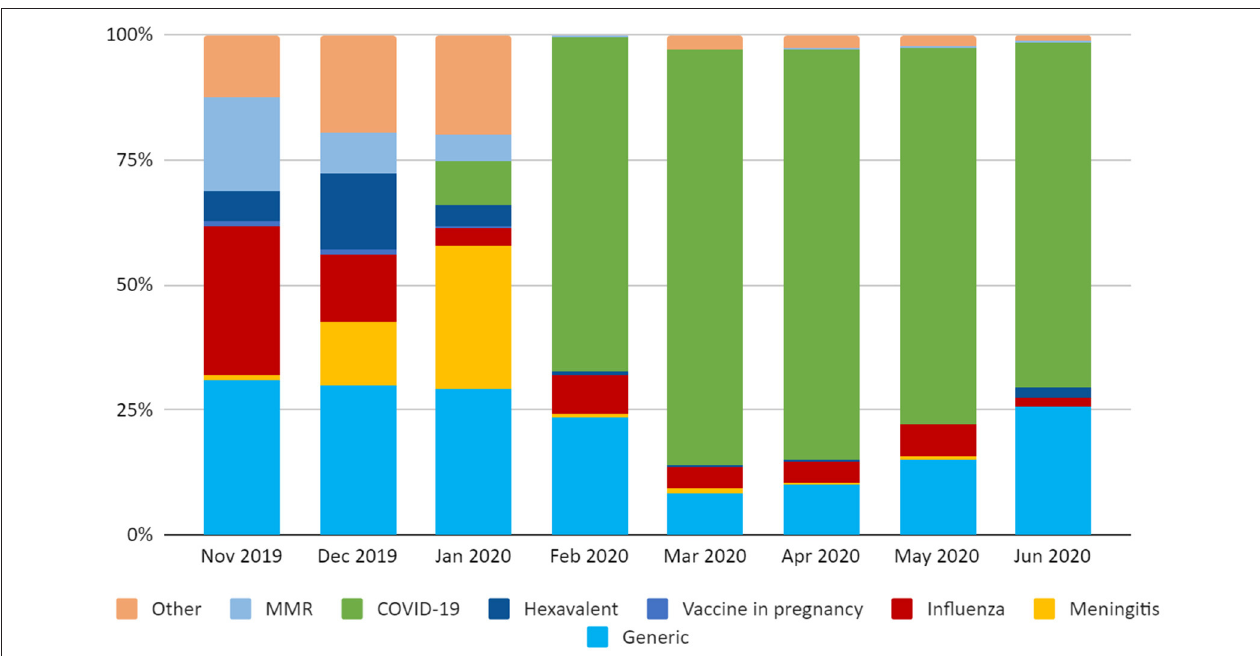
FIGURE 1 | Monthly distribution of the kind of vaccine mentioned in the tweets in the study period.